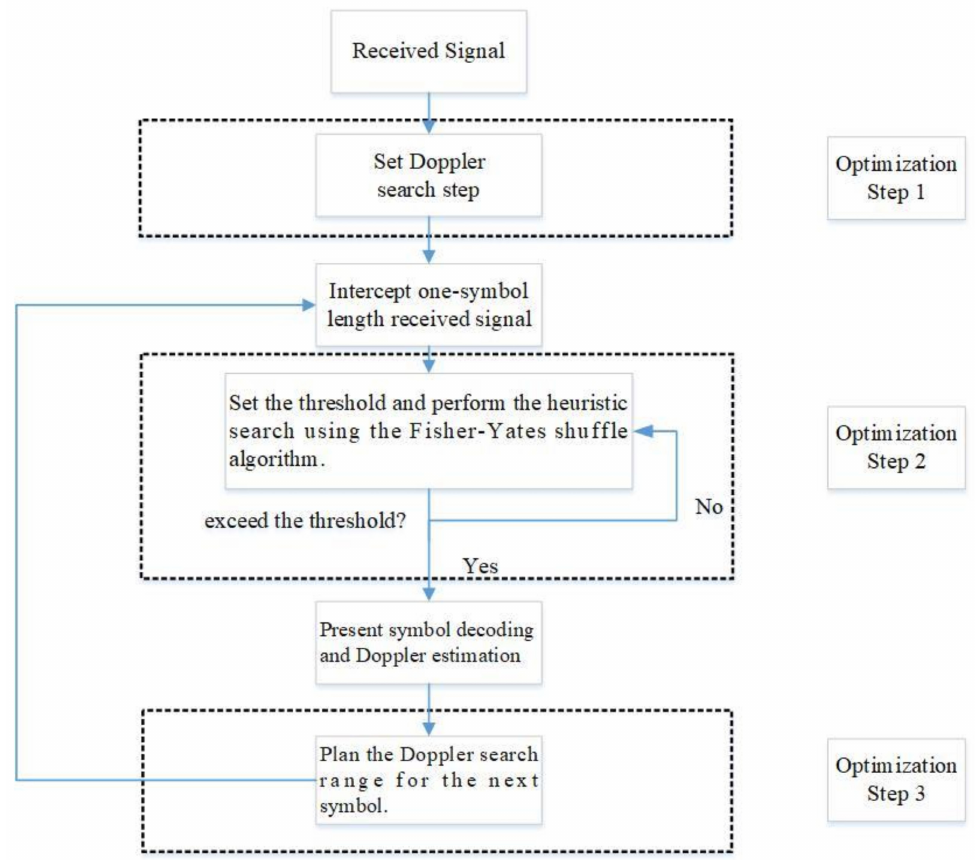
Figure 11. Optimization flow